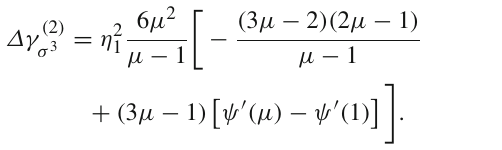
O = { σ 4 , σ∂ 2 σ, ∂ 2 σ 2 }